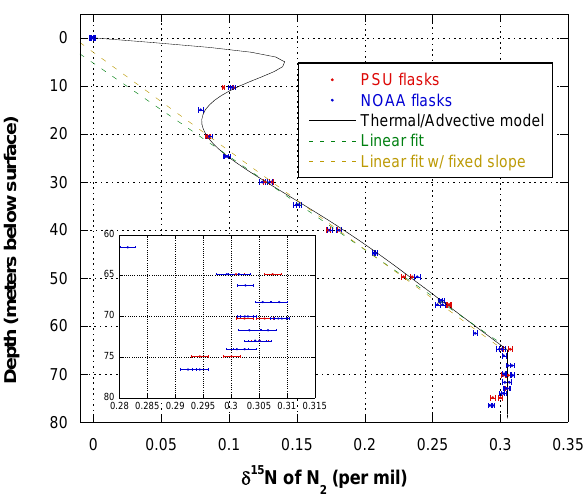
Fig. 2. Measured and modeled δ 15 N of N 2 in firn air from WAIS-D. Values are reported relative to air collected in La Jolla, CA. Mea- surements made on sets of flasks from NOAA and Penn. State Uni- versity (see text) showed no systematic differences. The inset sim- ply enlarges the scale on those collections made in, and immediately above, the lock-in zone. Model results are from the third model, in- corporating thermal gradients and advection, as well as gravitation and eddy diffusion (see Sect. 5). Also shown are linear fits to the NOAA flasks collected between 34 and 56m, with the slope fixed to the theoretical value, and with the slope as a free